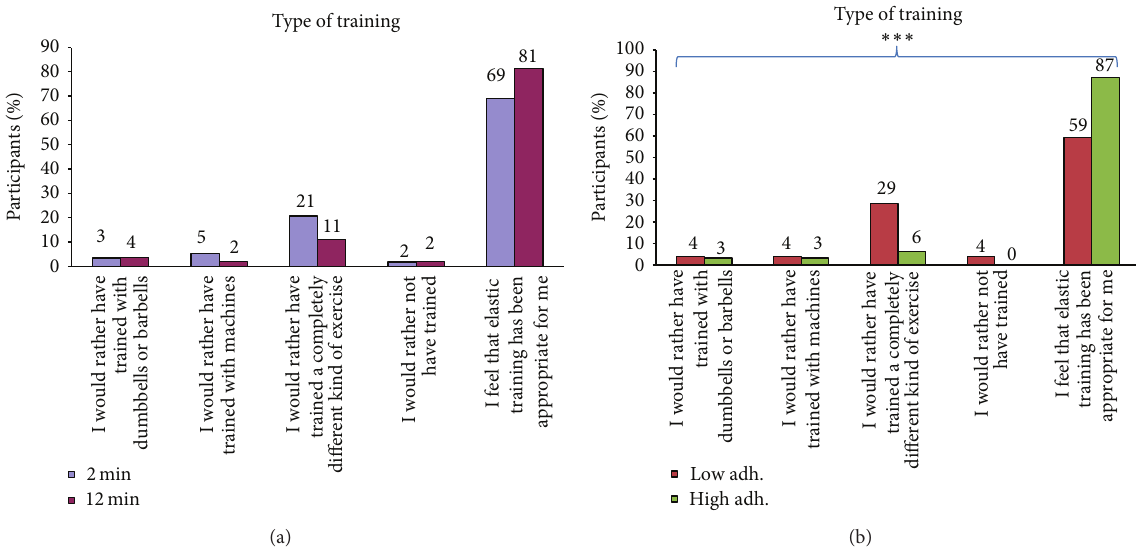
Figure 3: (a) Follow-up questionnaire (satisfaction, barriers, and facilitators). Participant feedback on the type of training in the 2 and 12 min groups. (b) Follow-up questionnaire (satisfaction, barriers, and facilitators). Participant feedback on the type of training among those with low and high adherence. ∗∗∗ Significant difference (Fisher’s exact test, 𝑃 < 0.001 ).